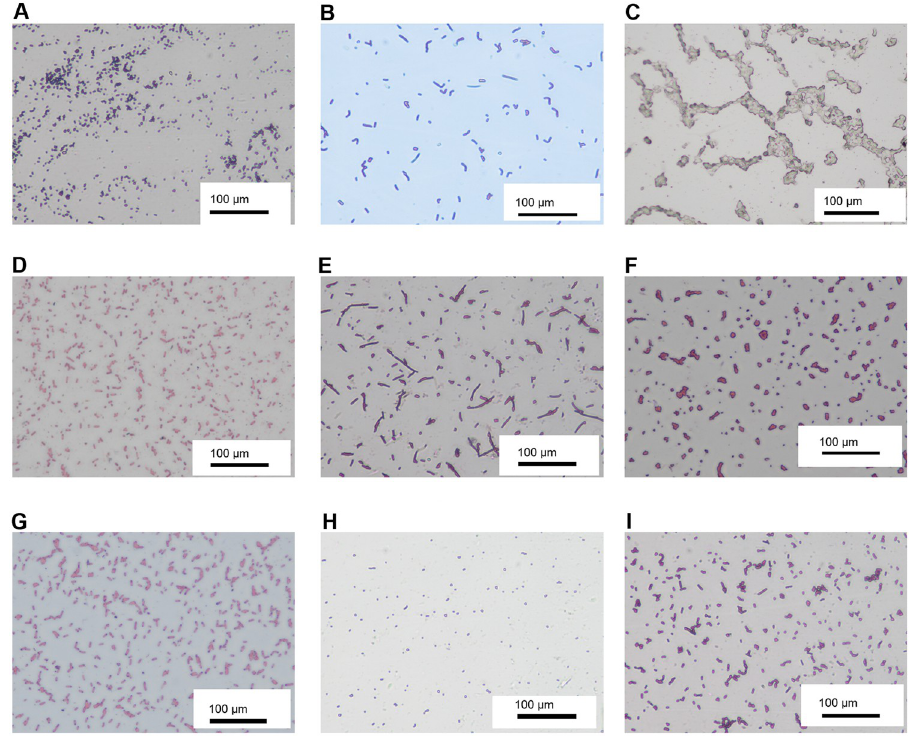
Fig 3. Microbial specimens from rat feces under a microscope on day 4 (methylene blue staining, x100). (A) Staphylococcus aureus , (B) Bifidobacterium , (C) yeast, (D) Bacteroides , (E) Clostridium , (F) anaerobic bacteria, (G) Escherichia coli , (H) Enterococcus and (I) Lactobacillus .